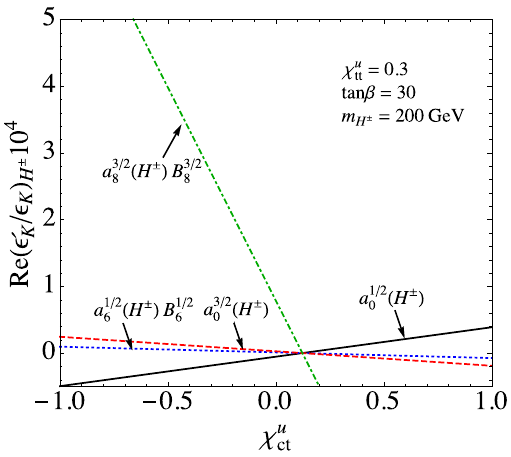
Figure 7 . Each contribution of a 1 = 2